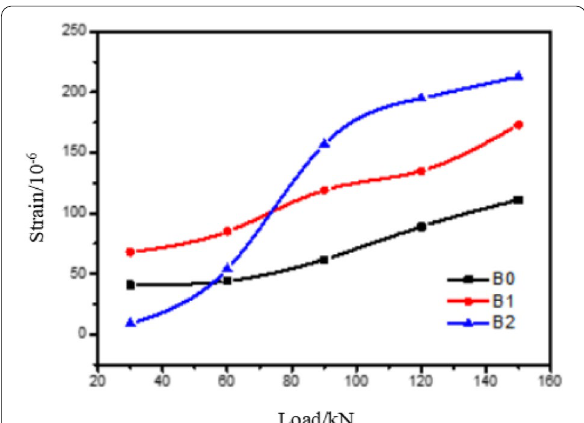
Fig. 9 Through the thickness strain comparison of different concrete